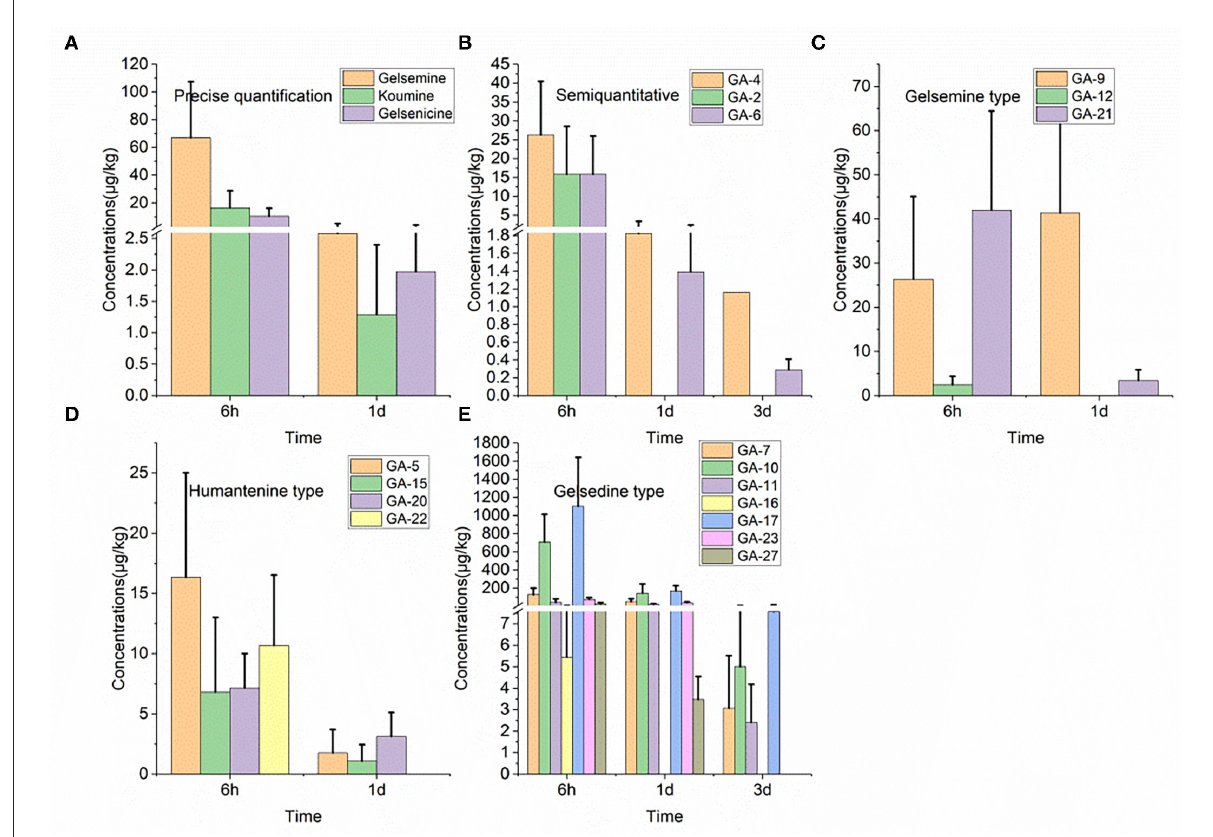
FIGURE4 (A–E) Depletion of Gelsemium alkaloids in pig urine after 45 d of consecutive administered G. elegans powder at a dose of 2% per kilogram